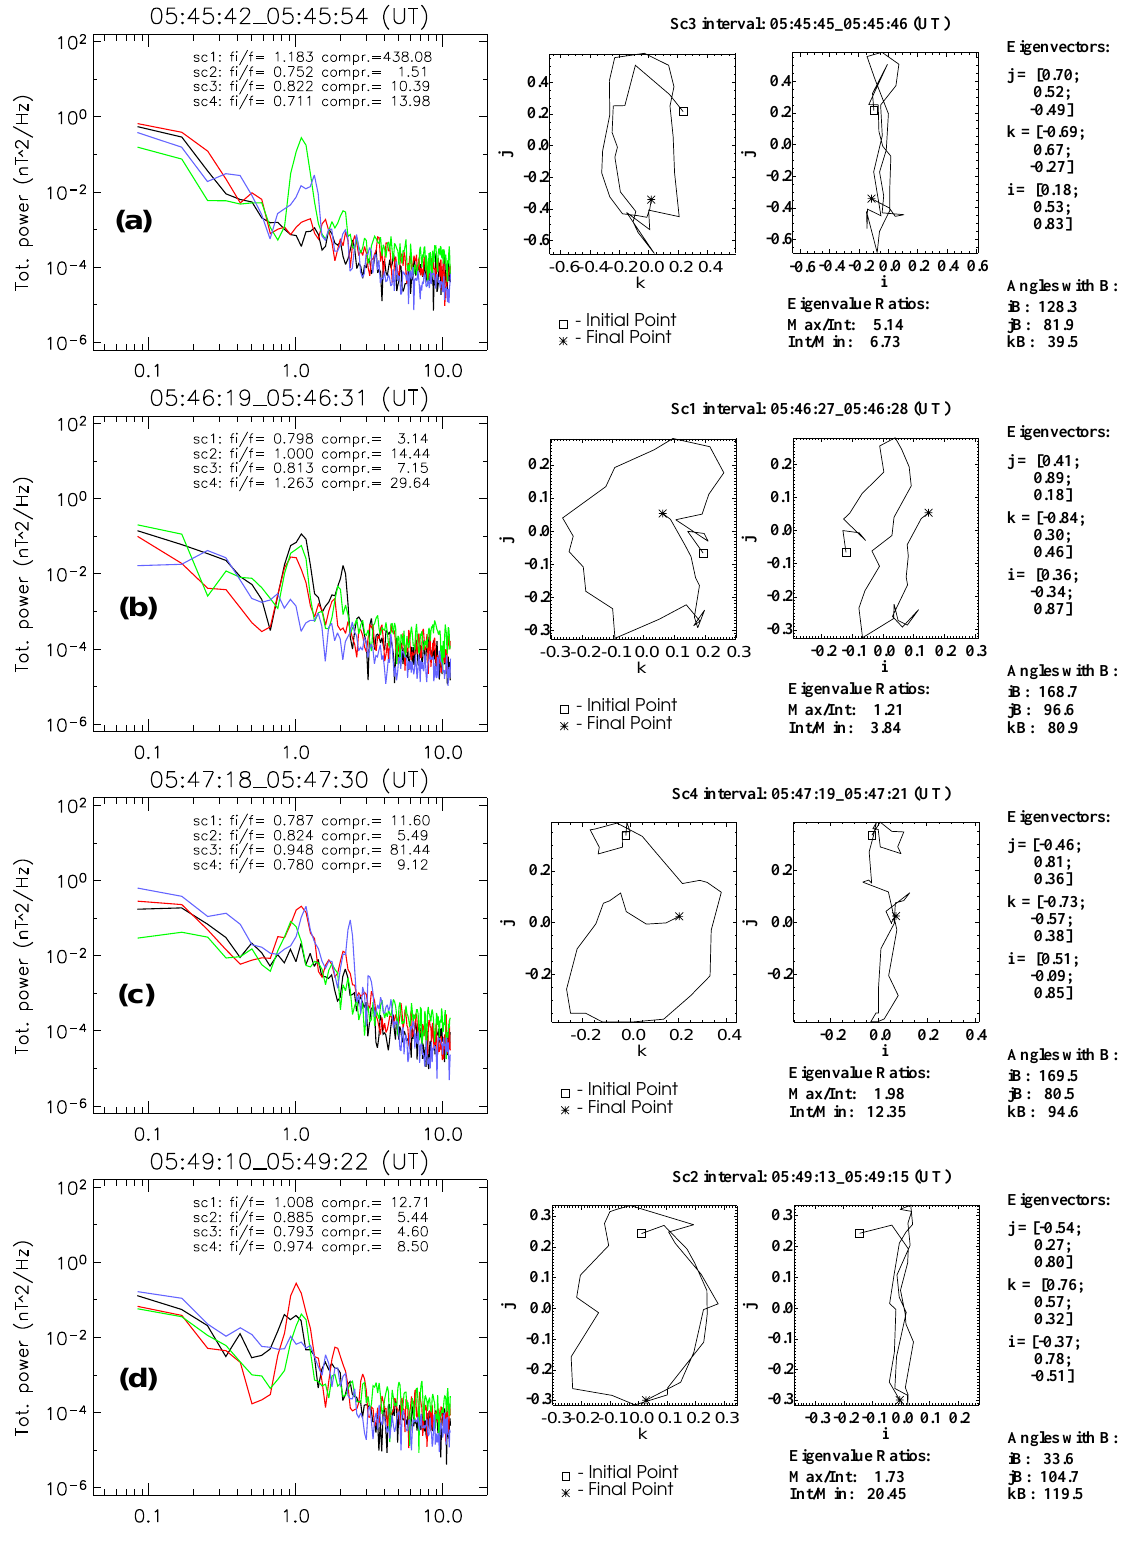
Fig. 13. Total power of magnetic field fluctuations at 05:45:42–05:45:54 UT (a) , 05:46:19–05:46:31 UT (b) , 05:47:18–05:47:30 UT (c) and at 05:49:10–05:49:22 UT (d) . On right-hand side are hodograms of the wave magnetic field observed by SC3 05:45:45–05:45:46 UT (a), by SC1 between 05:46:27–05:46:28 UT (b), by SC4 between 05:47:19–05:47:21 UT (c), and by SC2 between 05:49:13–05:49:15 UT